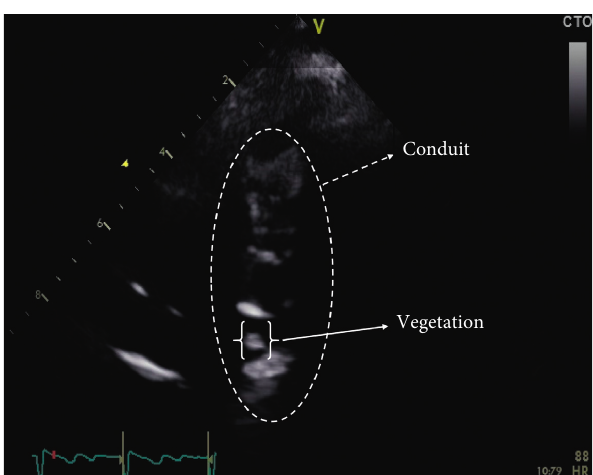
Figure 1: Transthoracic echocardiogram (TTE): a calcified vegetation, 4.0mm × 3.0mm in size, with independent mobility, was identified inside the conduit.